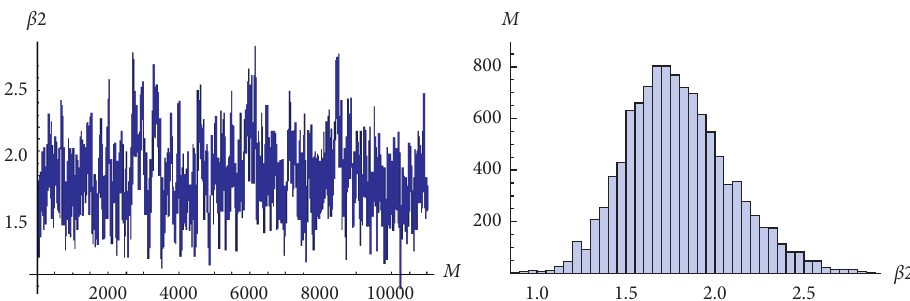
Figure 3: Simulation MCMC generated number/histogram of the parameter α